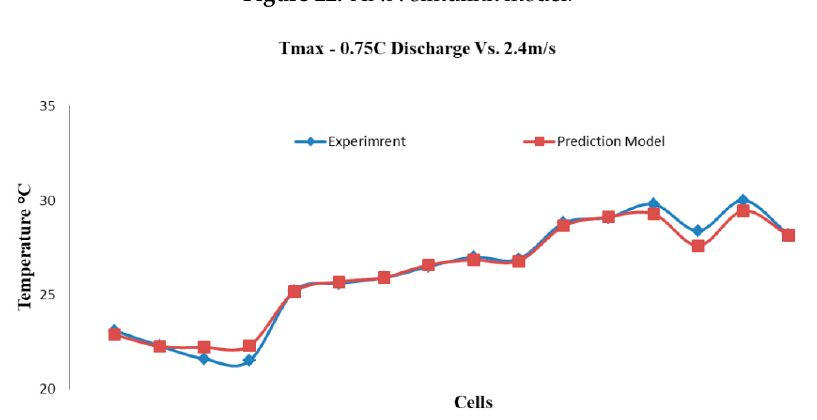
Figure 22. ANN simulink model.